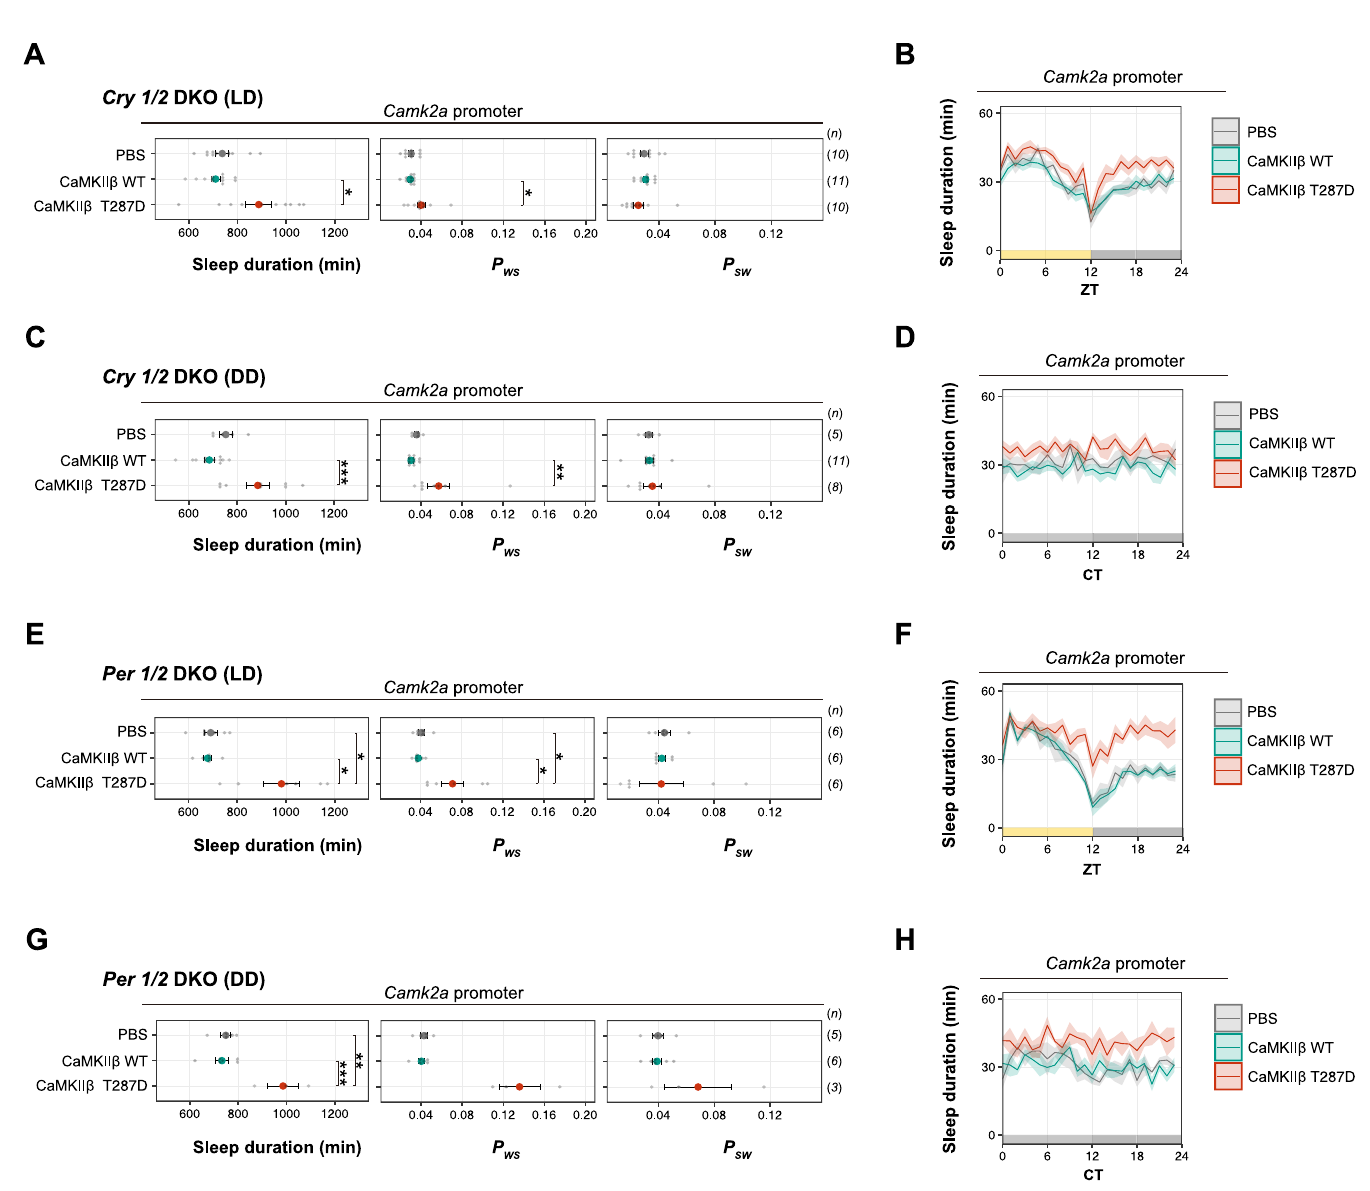
Fig 4. Sleep induction by CaMKII β T287D mutant is independent from core circadian clock genes. (A-D) Sleep/wake parameters and sleep profiles, averaged over 4 days, of Cry1/2 DKO mice expressing WT CaMKII β or the T287D mutant under the LD condition (A and B) or DD (C and D) . Multiple comparison tests were performed between all individual groups. (E-H) Sleep/wake parameters and sleep profiles, averaged over 4 days, of Per1/2 DKO mice expressing WT CaMKII β or the T287D mutant under the LD condition (E and F) or DD (G and H) . Multiple comparison tests were performed between all individual groups. The underlying data can be found in S1 Data. Error bars: SEM, � p < 0.05, �� p < 0.01, ��� p < 0.001, n.s.: no significance. CaMKII β , calmodulin-dependent protein kinase II β ; CT, circadian time; DD, constant dark; DKO, double knockout; LD, light/dark; WT, wild-type; ZT, zeitgeber